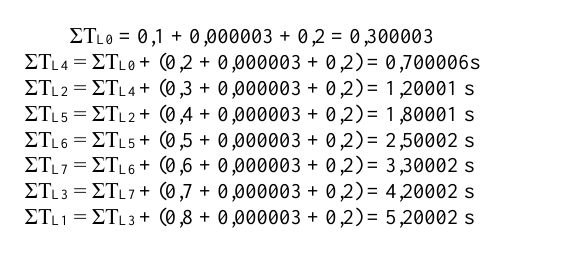
Table 1. Contribution of latency individually by network nodes